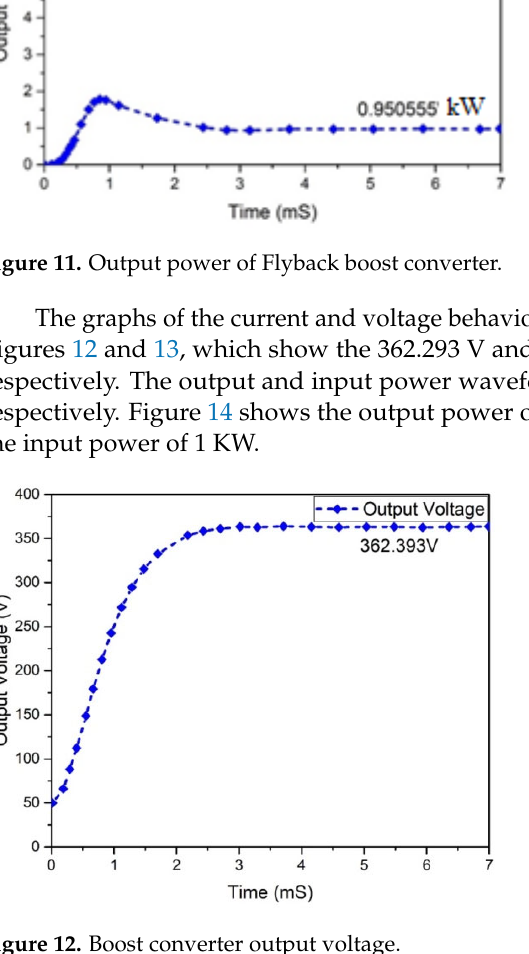
Figure 12. Boost converter output voltage.